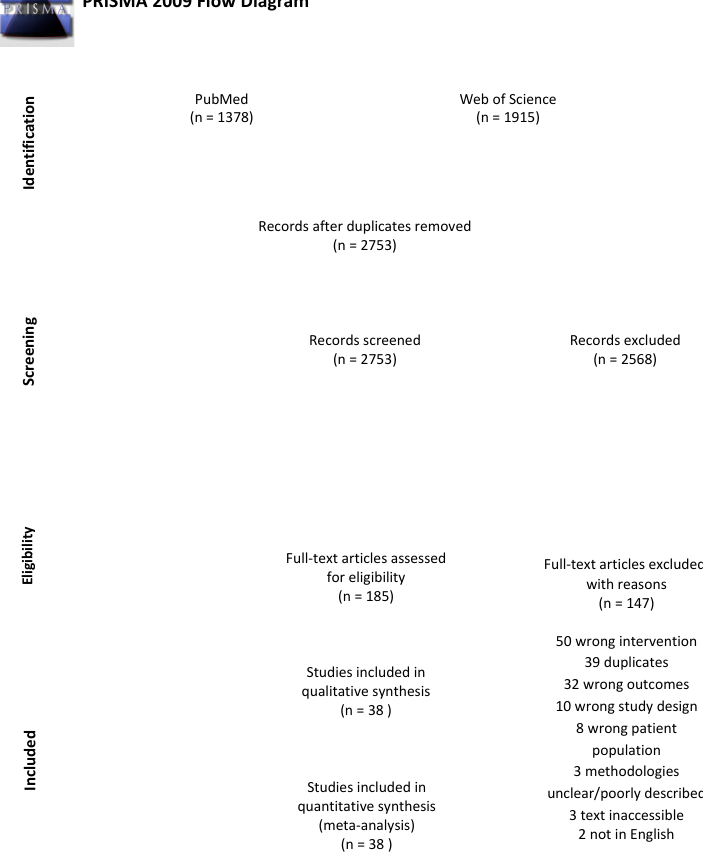
Figure 1. Preferred Reporting Items for Systematic Reviews and Meta-Analyses (PRISMA) flow diagram of included articles .